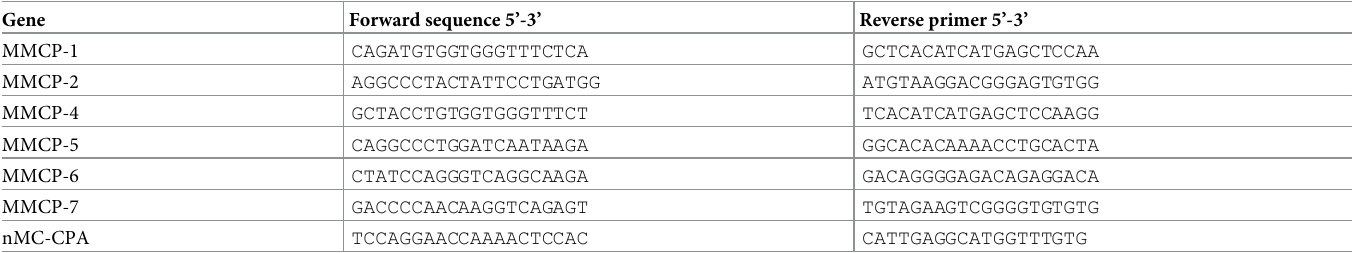
Table 1. List of primers for